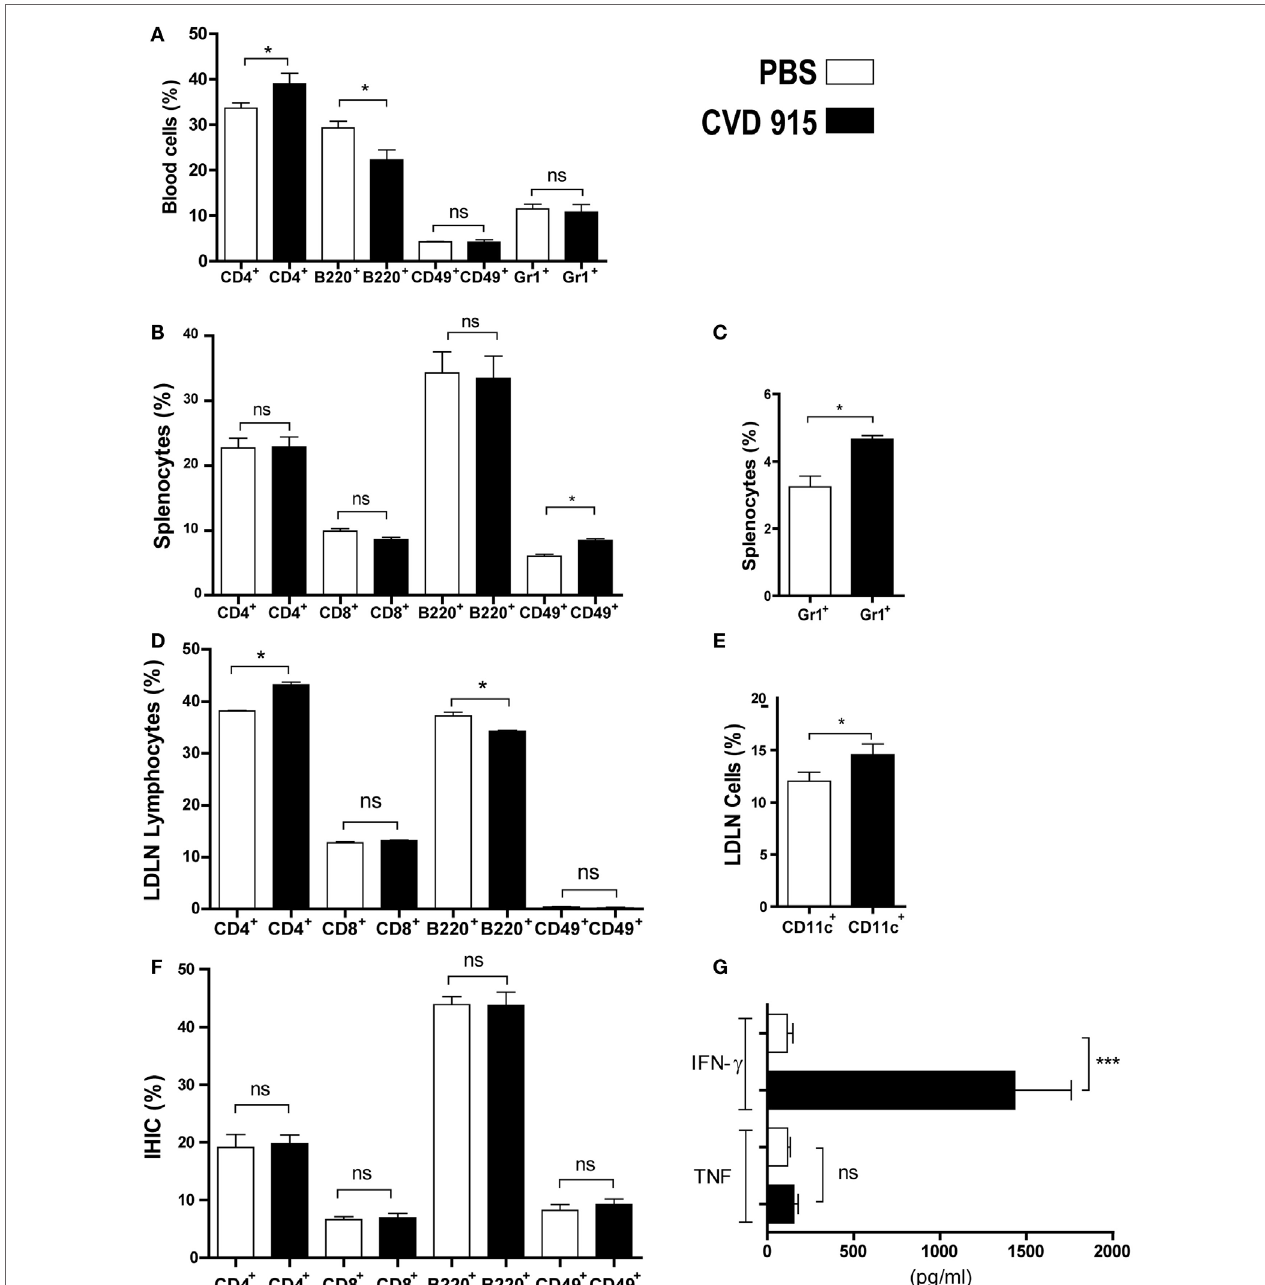
FigUre 1 | early immune response with iFn- γ production in liver of naive mice after oral Salmonella administration . BALB/c mice were immunized with CVD 915 via o.g. or PBS as a control. After 24 h, animals were sacrificed for sampling. (a–F) Cell phenotype of individual mice was analyzed by flow cytometry ( n = 3–13). (a) Percentage of blood cells. (B) Percentage of splenic lymphocytes. (c) Percentage of splenic neutrophils. (D) Percentage of lymphocytes from liver-draining lymph nodes (LDLN). (a–D) * p < 0.05; ns, not statistically significant. Data are from one experiment representative of three to five. (e) Percentage of CD11c + cells between LDLN cells, gated on DC region as defined in Section “Materials and Methods.” * p < 0.05. (F) Percentage of lymphocytes from intrahepatic immune cells (IHIC). ns, not statistically significant. (e,F) Data are from three experiments. (g) IFN- γ and TNF levels produced by IHIC measured by ELISA. The limits of detection were 30 and 4 pg/ml, respectively. *** p < 0.001; ns = not statistically significant ( n = 9). Data are from two